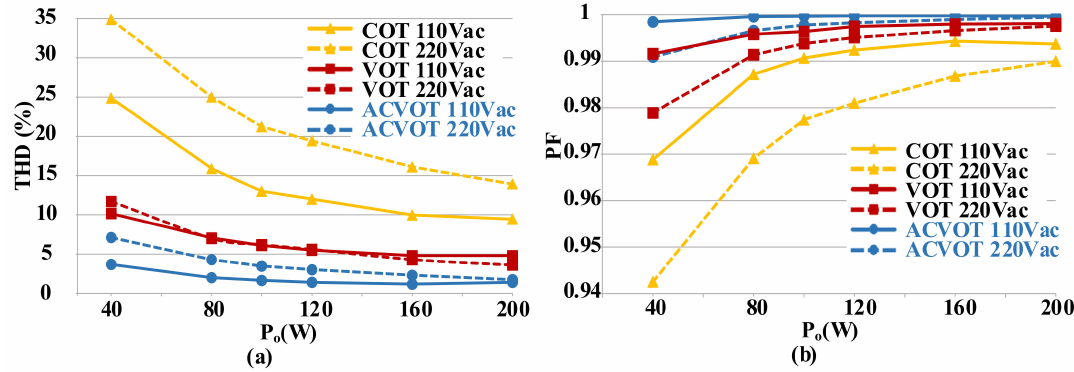
Figure 16. Measured input current PF and THD comparison: ( a ) THD; ( b ) PF.